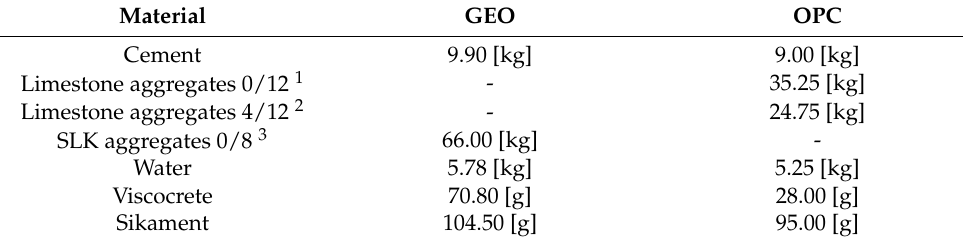
Table 1. Formulation of the GEO and OPC concretes.